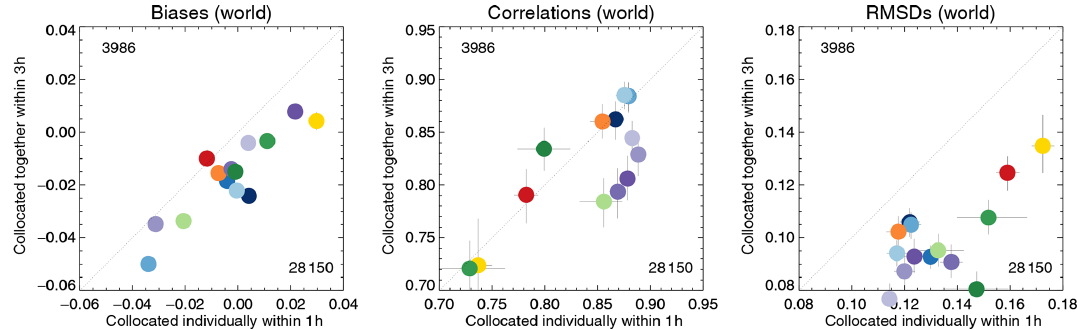
Figure 20. Comparison of the evaluation of satellite products for different dataset collocations. Horizontal axis: individual collocation with AERONET (within 1h). Vertical axis: combined collocation of morning or afternoon products with AERONET (within 3h). Colours indicate the satellite product; see also Fig. 1. Numbers in the upper left and lower right corner indicate the amount of collocated data, averaged over all products. The AERONET data are the Kinne et al., 2013, selection, pruned. Error bars indicate the 5%–95% uncertainty range, based on a bootstrap sample of 1000.